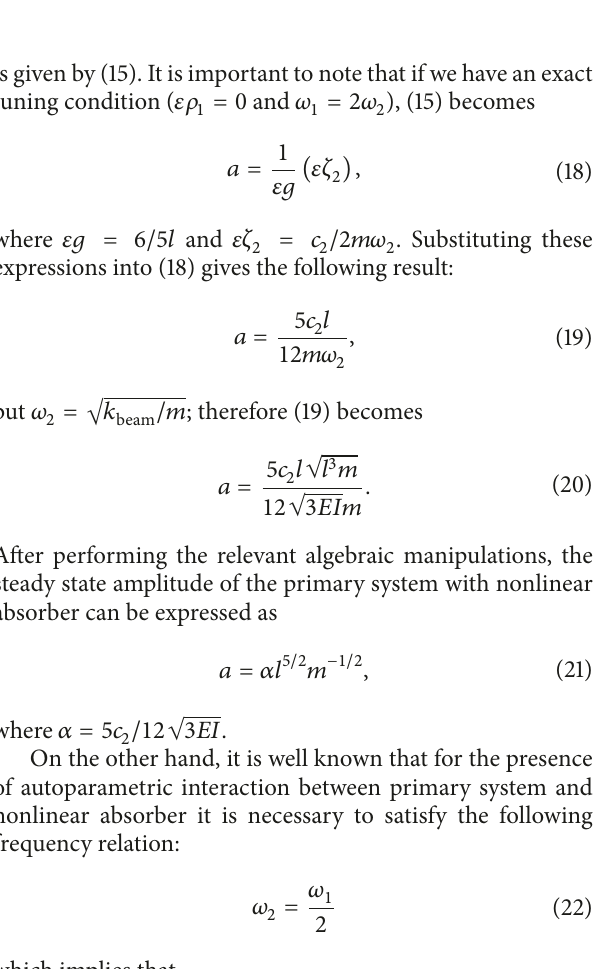
Figure 5: Frequency response for the autoparametric